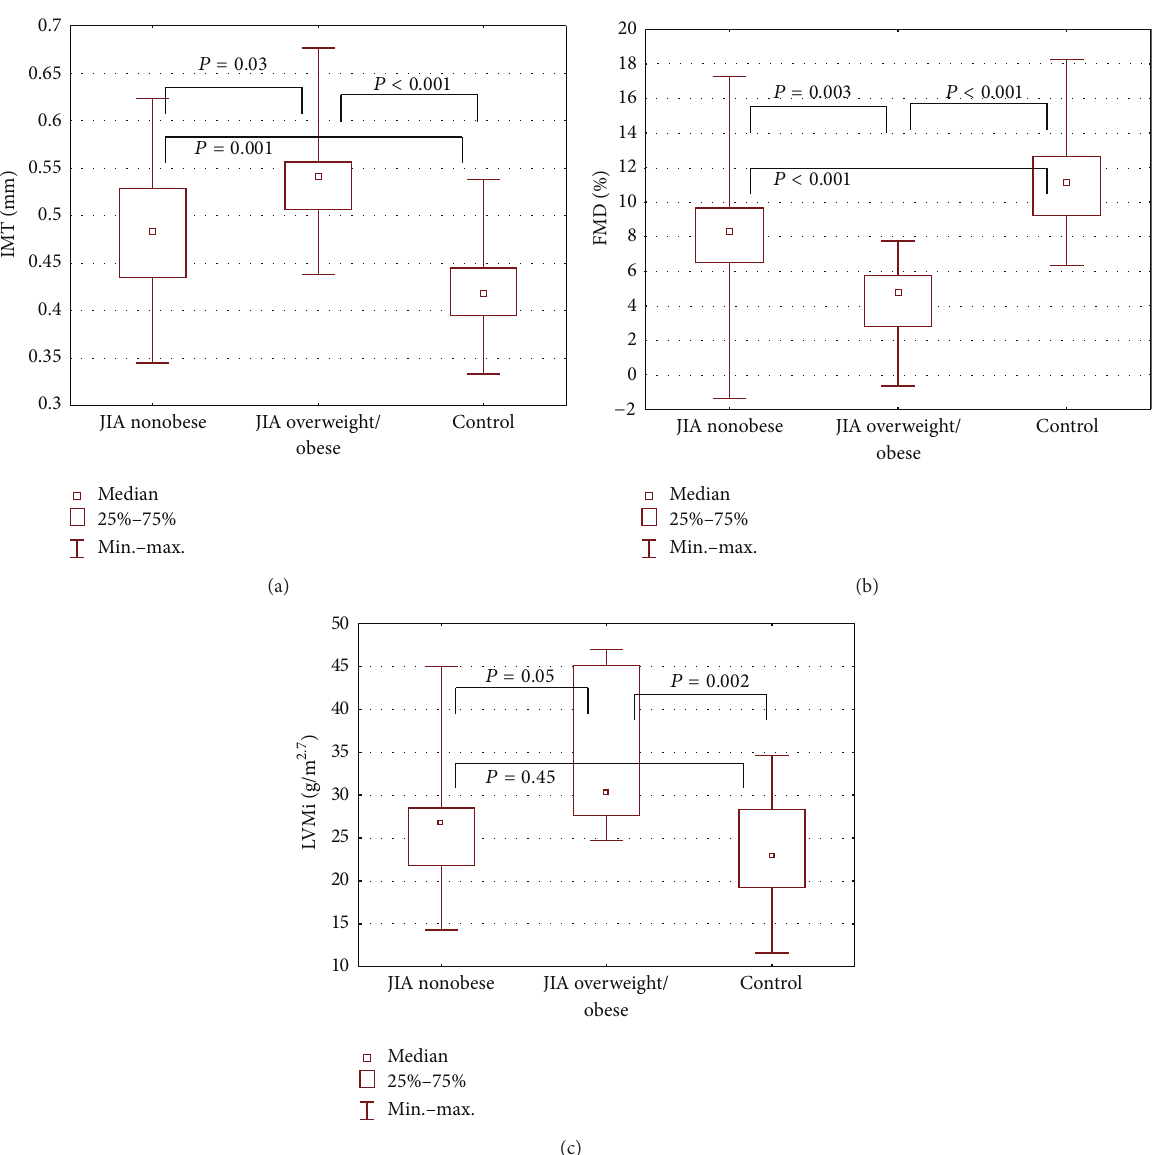
Figure 1: Subclinical changes in the cardiovascular system in 58 children and adolescents with juvenile chronic arthritis (JIA) divided depending on presence of excess body mass (nonobese JIA, overweight/obese JIA, controls). (a) Intima-media thickness (IMT), (b) endothelial function—flow mediated dilation (FMD), and (c) indexed left ventricle mass (LV mass indexed by height in meters raised to the power of 2.7 to minimize the effect of age, gender, and body